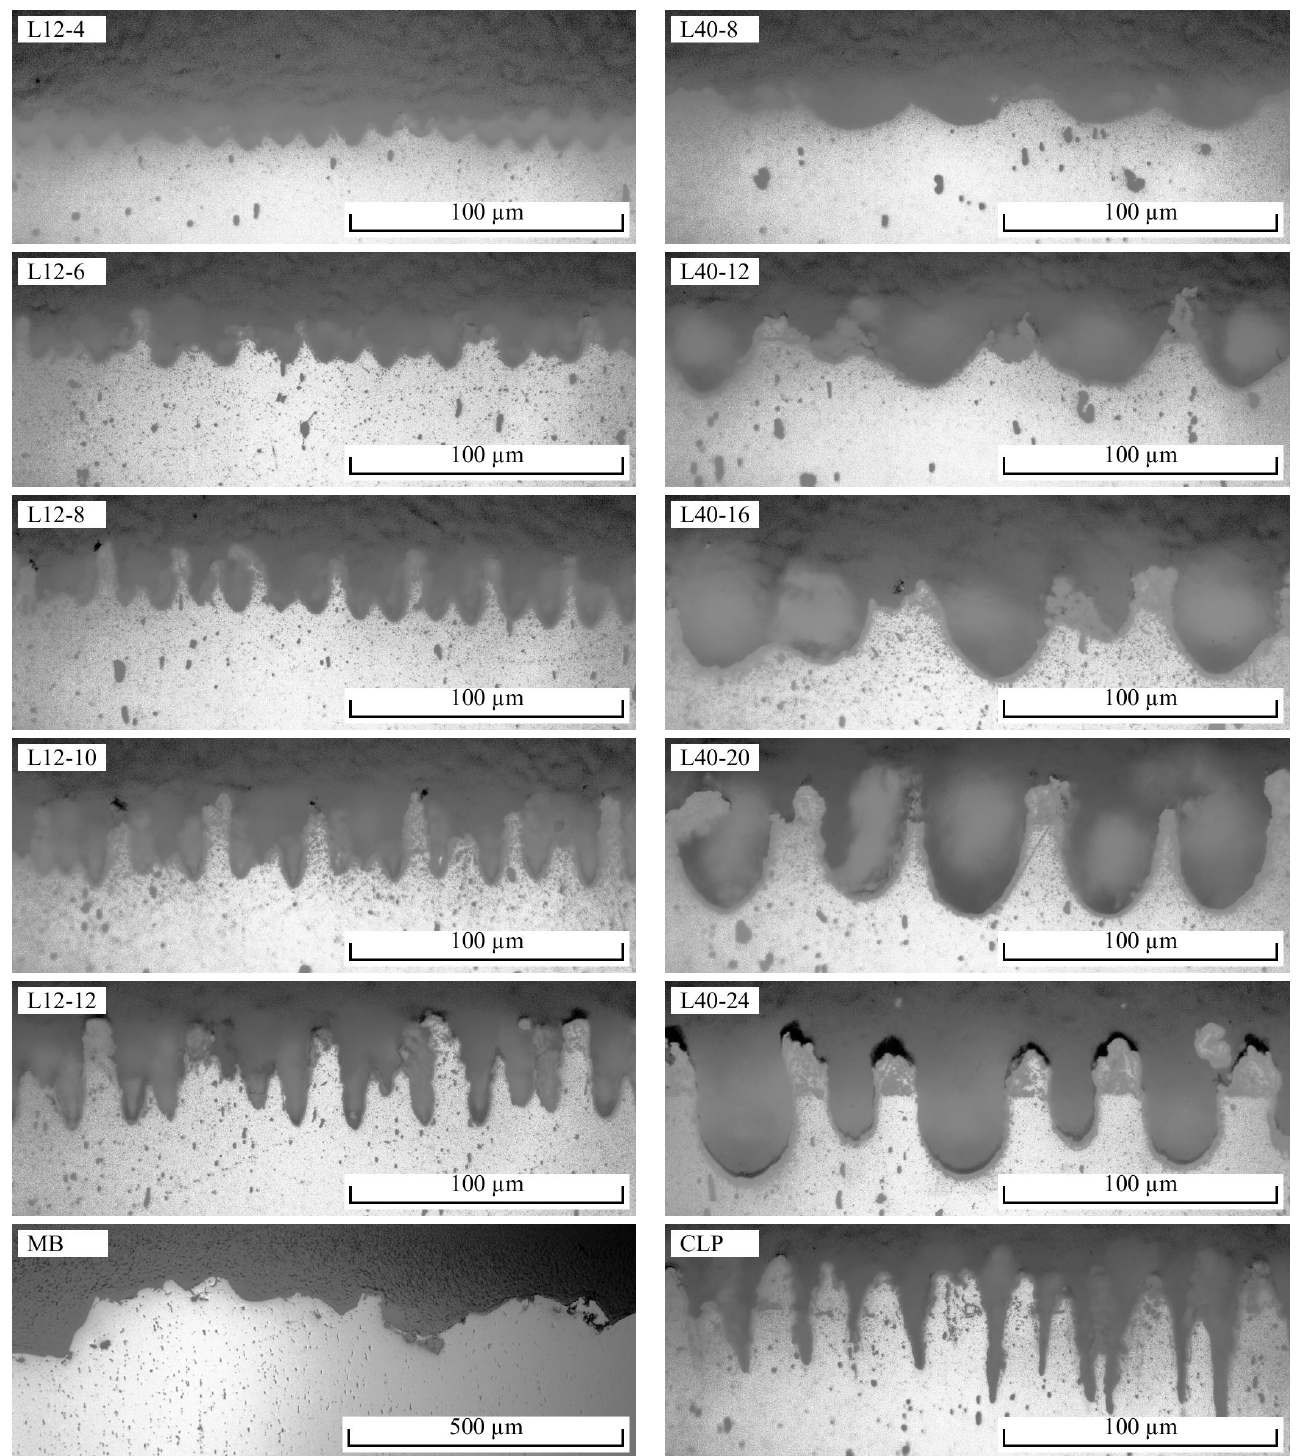
Figure 6. Optical microscopy images of the cross-sections of all joined